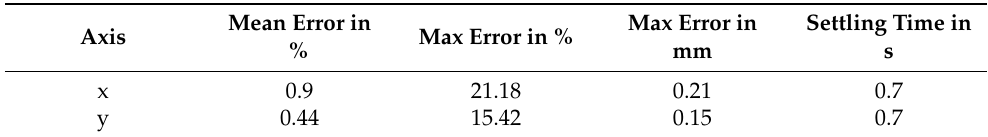
Figure 11. Displacement error and current reference i ∗ without current controller dynamics for one single AMB with constant reference positions. Table 1. Error metrics of the experiment neglecting current controller dynamics, with one bearing, constant reference positions and external disturbance forces.